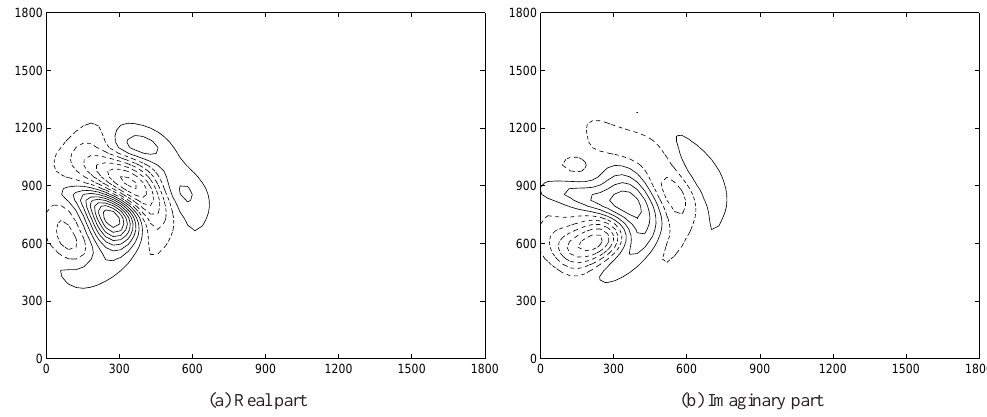
Fig. 4. Oscillatory mode associated with the first Hopf bifurcation H 0 in Fig. 2. (a) Real and (b) imaginary part of the oceanic stream Fig. 4: Oscillatory mode associated with the first Hopf bifurcation H ′ 1 in Fig. 2. (a) Real and (b) 1 function ψ oc ; contours every 2 × 10 − 4 imaginary part of the oceanic stream function ψ oc ; contours every 2 × 10 − 4 .